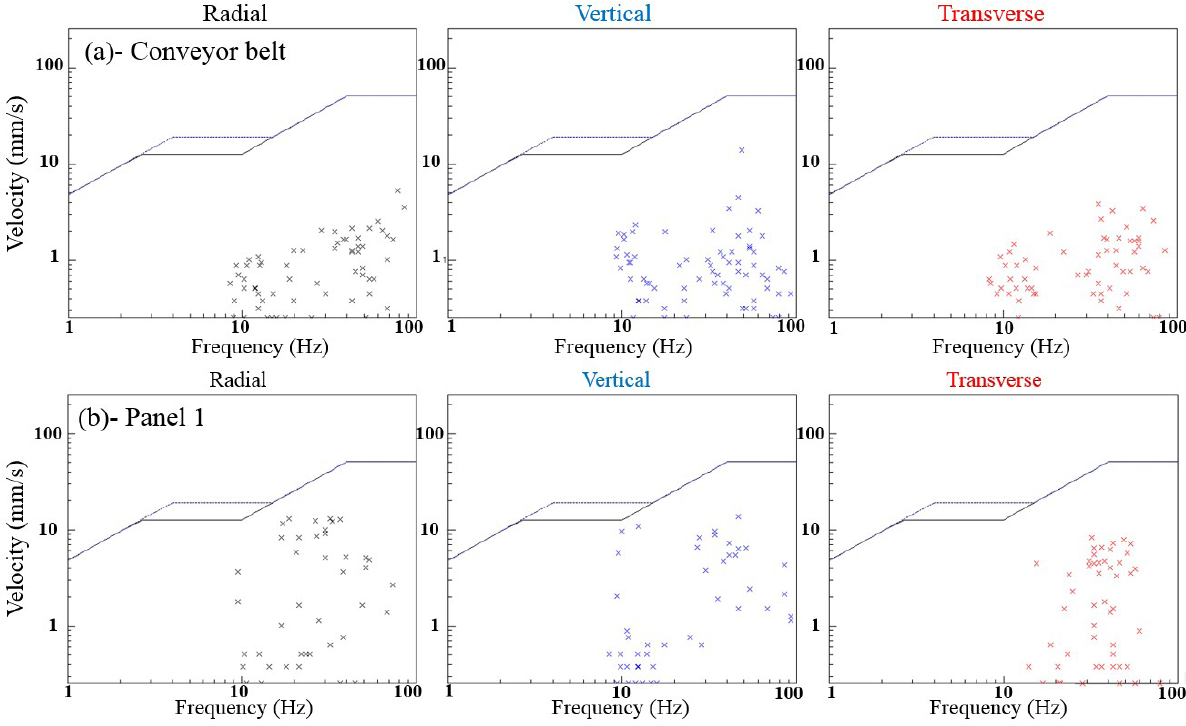
Figure 5: PPV and its associated frequencies with USBM RI 8507 criterion. (a) “Conveyor belt” site , (b) “Panel 1 (Upper exploitation level)” site.